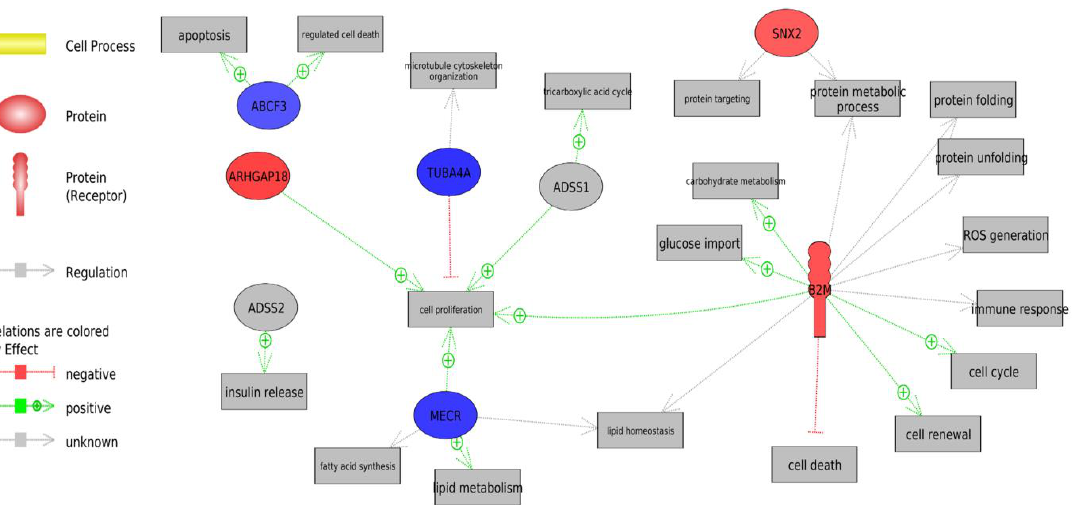
Figure 2. Biological processes associated with biomarkers related to the residual feed intake trait (RFI). The genes highlighted in red are up-regulated in low residual feed intake (LRFI) group, the blue circles present the down-regulated genes in the LRFI group compared with the high residual feed intake (HRFI) group; the green arrows indicate a positive regulation effect, while the red arrows denote a negative regulation effect.